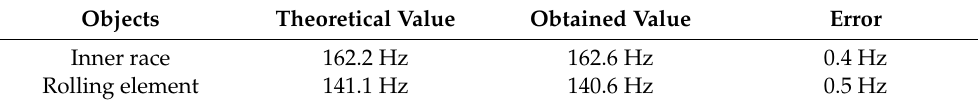
Table 2. Calculation error between the theoretical value and the obtained